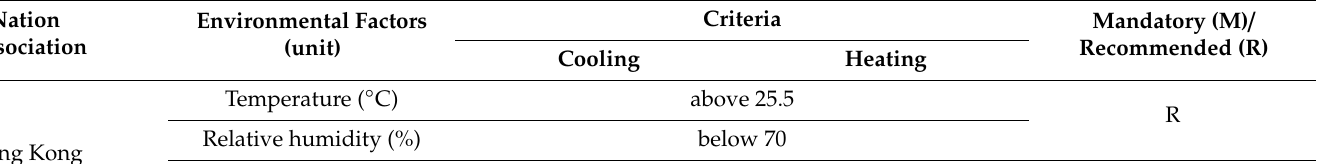
Table 1. Major countries and associations standard for thermal environment of o ffi ce